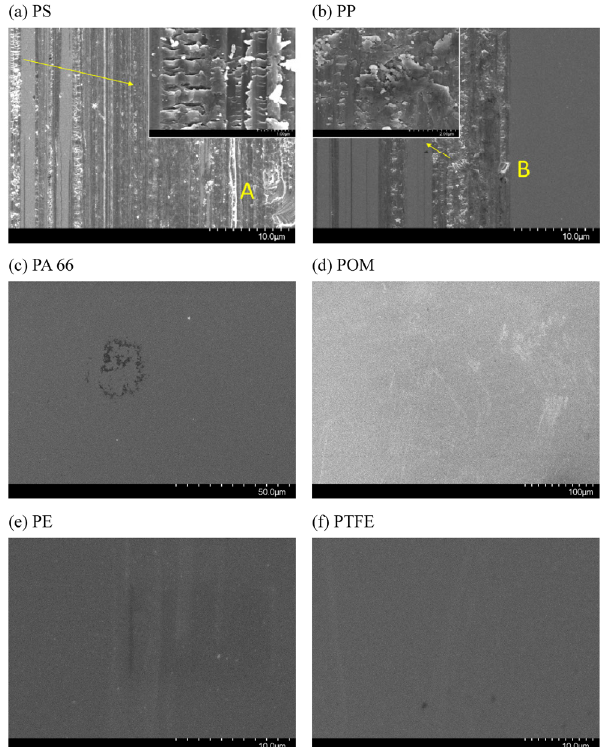
Fig. 9 Morphology of the silicon surface after rotational friction with different polymer spheres with an inclined contact. (a) PS; (b) PP; (c) PA 66; (d) POM; (e) PE; and (f)